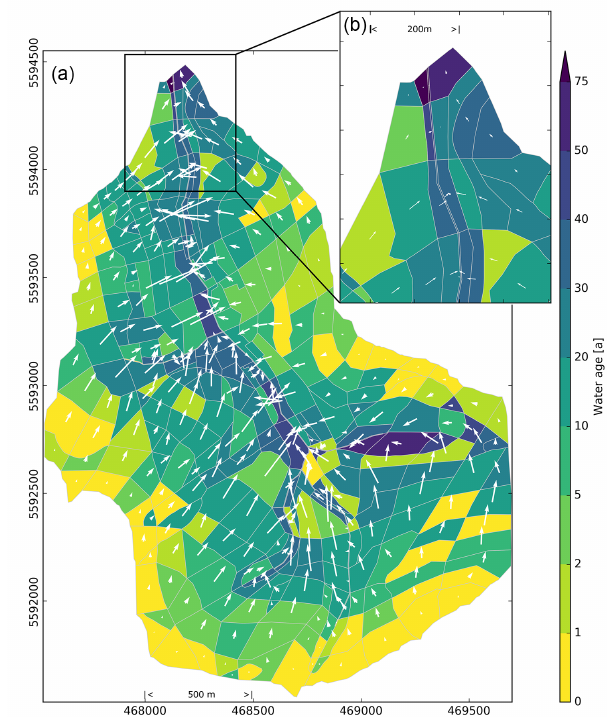
Figure 10. Maps of modelled groundwater ages (colour scheme) and flow directions (white arrows) of (a) the Vollnkirchener Bach subcatchment and (b) a detailed view of the northern part of the subcatchment. The length of the white arrows depicts the intensity of flow. UTM-32N (WGS84) coordinates on both